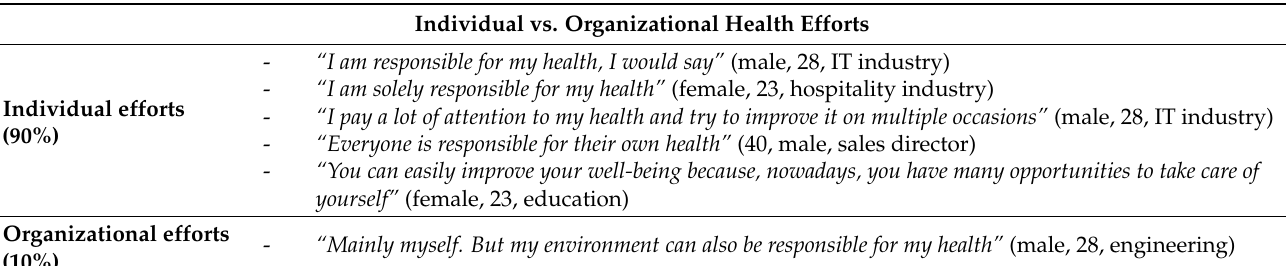
Table A2. Main themes and subthemes that emerged from the data analysis with sample quotes. Individual vs. Organizational Health